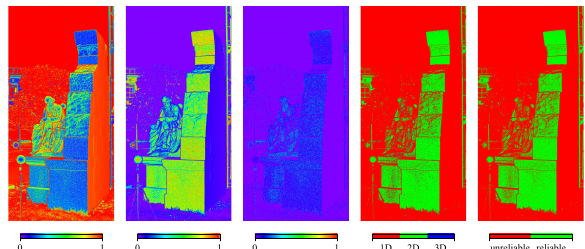
Figure 1. Range image, intensity image, visualization of range reliability, logarithmic representation of range reliability and the binary confidence map derived by thresholding based on a man- ually selected threshold of t σ = 0 . 03 m (from left to right).